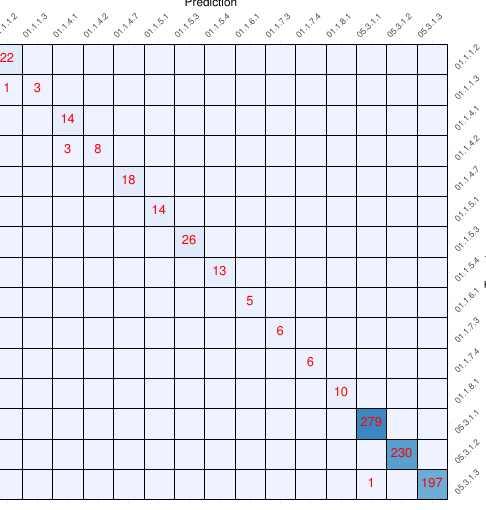
Figure 9. The confusion matrix for SVM with a radial kernel using the FastText skip-gram vectorization.